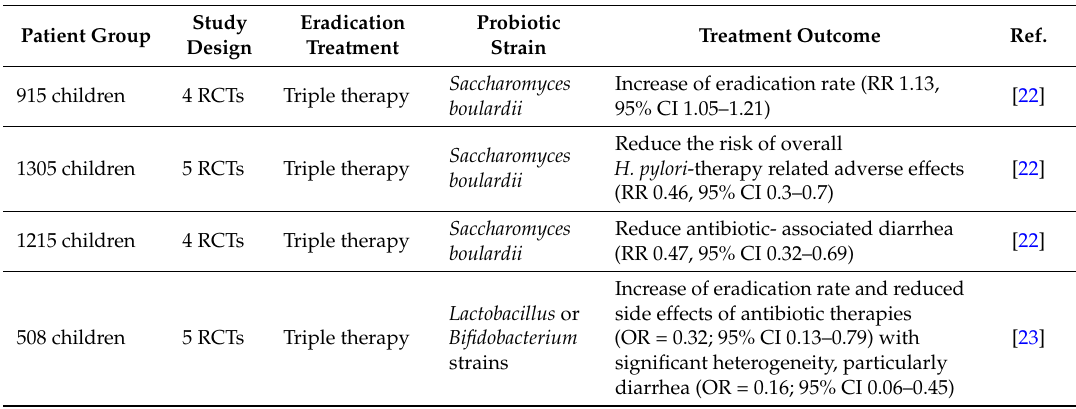
Table 2. Meta-analyses of probiotics supplementation in